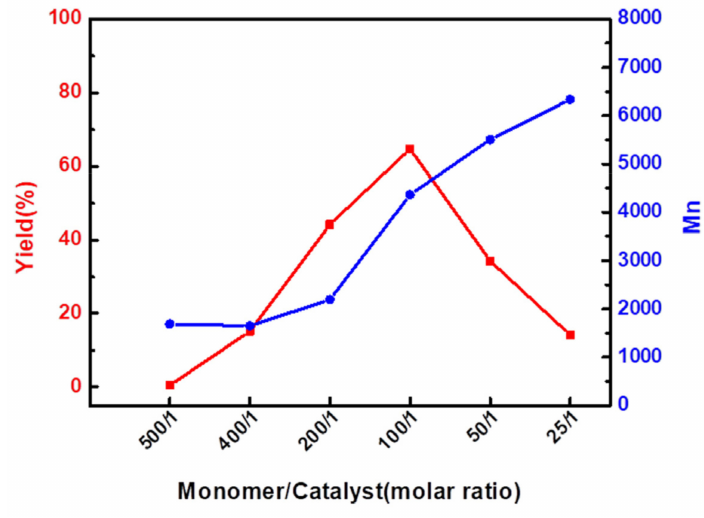
Figure 3. Yield (left) and number average molecular weight (right) vs. catalyst molar ratio of Eug-HDI polymerization.